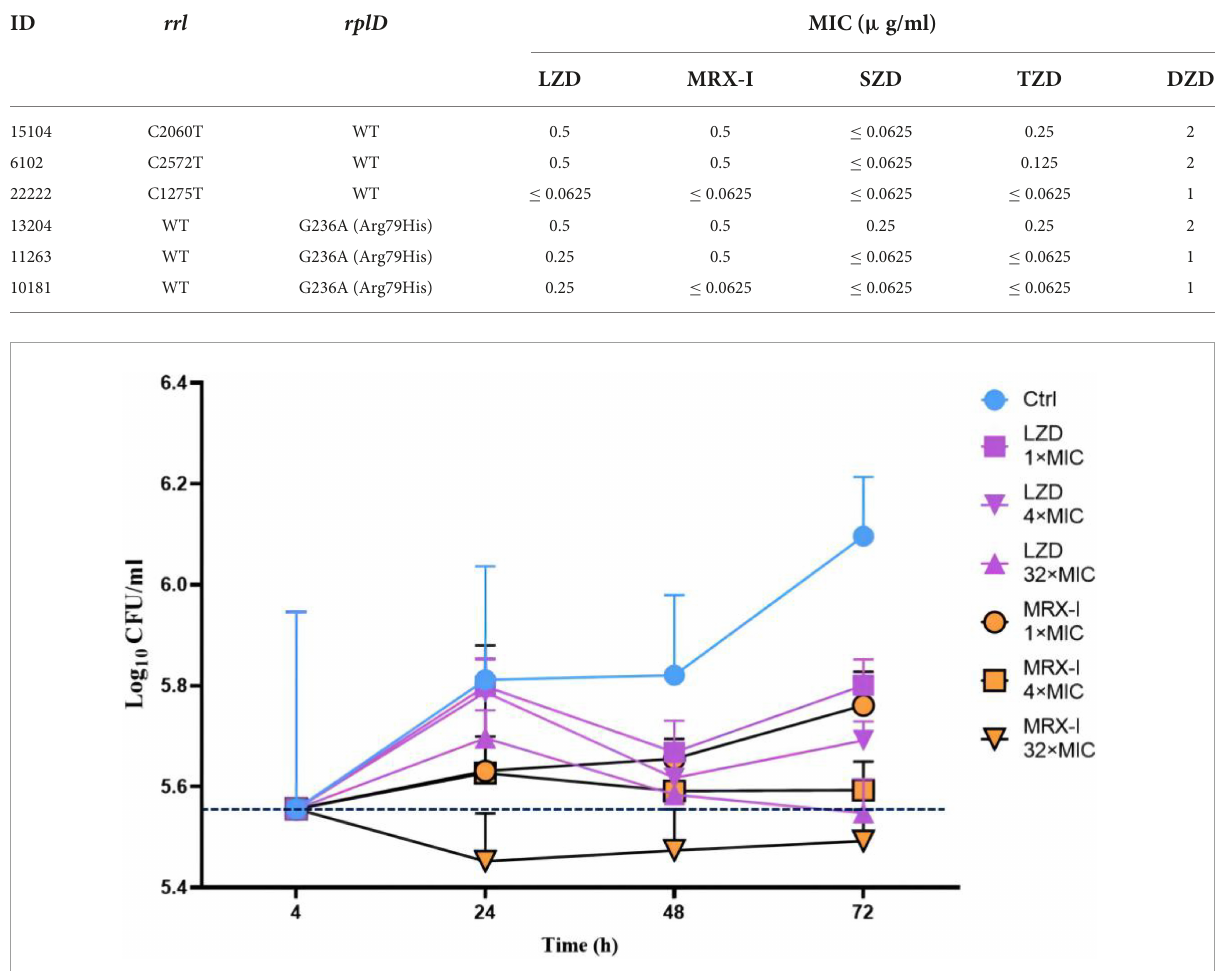
FIGURE2 Intracellular activities of antibiotics against H37Rv in the THP-1 macrophage model. Ctrl, control; LZD, Linezolid; MRX-I,